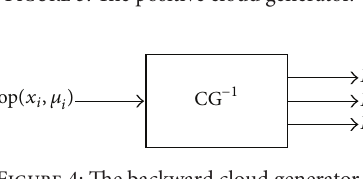
Figure 3: The positive cloud generator.